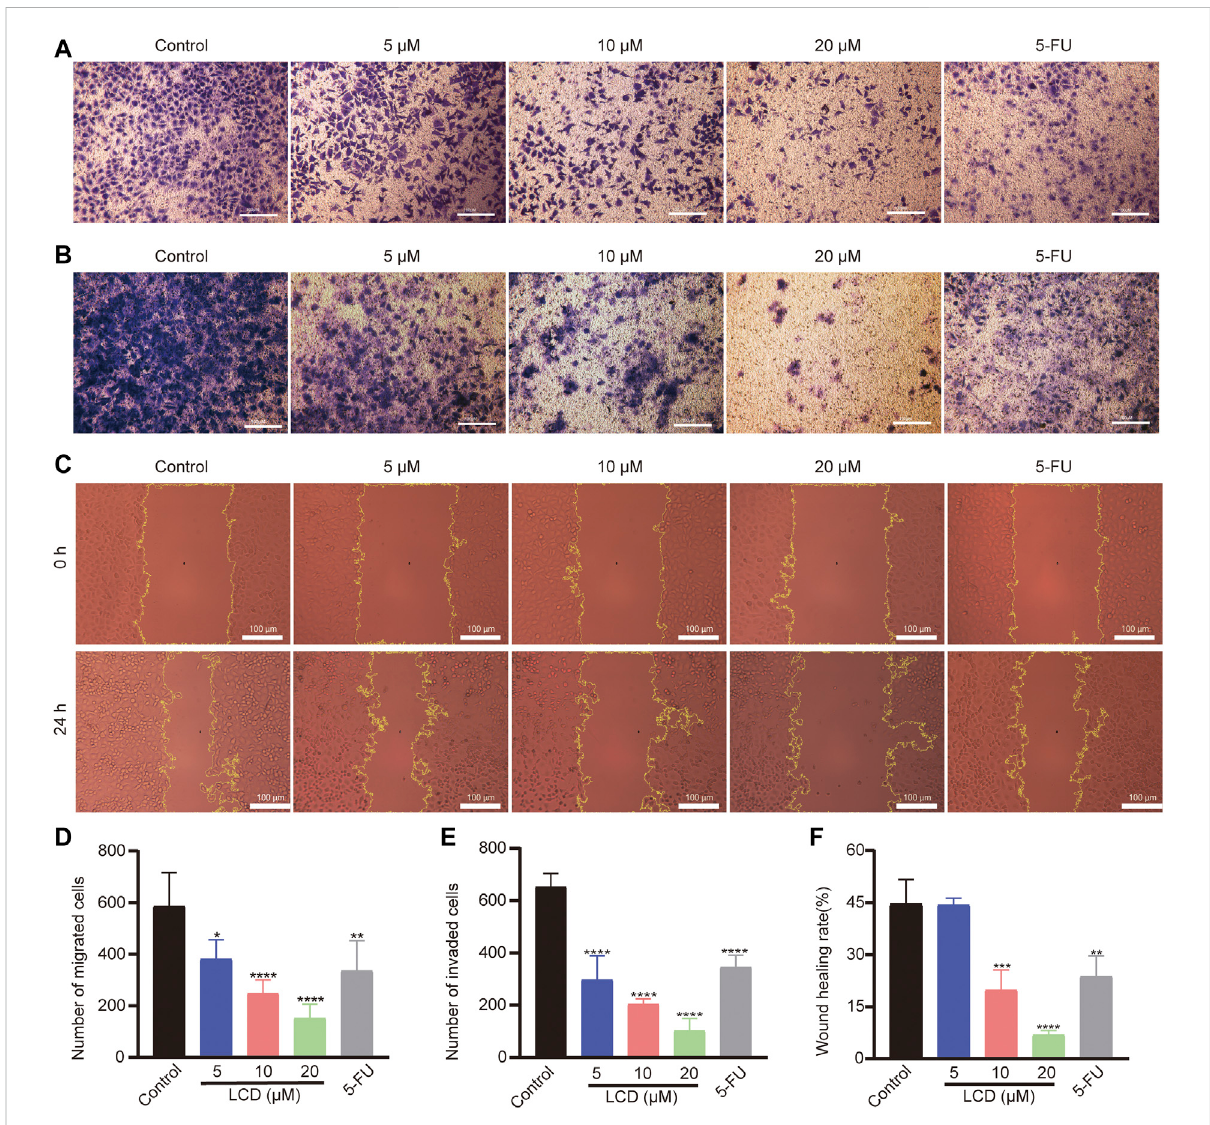
FIGURE 3 Licoricidin suppressed MGC-803 cell metastasis. MGC-803 cells were treated with licoricidin (5, 10, and 20 μ M) or 5- fl uorouracil 20 μ M for 24 h. Representative images of cell migration (A) and invasion (B) in each group were detected by transwell experiments (×200). The number of migrated (D) orinvaded (E) cellspassingthroughthemembraneineachwellwascountedfrom fi verandom fi eldsofviewandanalyzedasthemean± SD. (C,F) ComparisonofwoundhealingareasofMGC-803cellstreatedwithindicatedconcentrationfor24 h(×200).Thepartscircledinyellow linesrepresentareaswherethecellshadnotyetmigratedto fi ll. (G) ExpressionlevelsofMMP2andMMP9wereassessedbyWesternblotanalysisand normalized by β -actin for quantitative analysis. Results are displayed as mean ± SD of three independent experiments. * p < 0.05, ** p < 0.01, *** p < 0.001, and **** p < 0.0001. LCD, licoricidin. 5-FU, 5- fl uorouracil. Scale bar, 100 μ